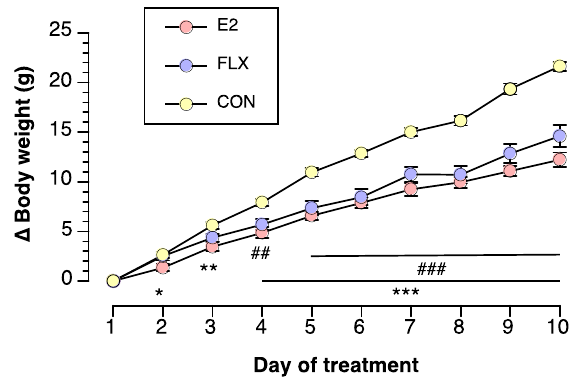
Figure 1. The effect of estradiol replacement or fluoxetine administration on body weight change from the onset of fluoxetine (FLX) treatment in ovariectomized female rats. Female rats were ovariectomized and assigned to the estradiol- or cholesterol-treated group. Six or seven days after ovariectomy, half of the cholesterol-treated rats were subcutaneously ( s.c. ) injected twice daily with 5 mg / kg fluoxetine (FLX) at Zeitgeber times (ZT) of 0 (ZT0) and 12 (ZT12), while the other half of the cholesterol-treated rats (CON) and all of the estradiol-treated rats (E2) were s.c. injected with the same volume of saline. Data are shown as the mean ± SEM ( n = 13 in CON, n = 14 in E2, and n = 13 in FLX). Note: *, **, and ***: significant differences at p < 0.05, p < 0.01 and p < 0.001, respectively, between the E2 and CON groups. ## and ###: significant differences at p < 0.01 and p < 0.001, respectively, between the FLX and CON groups.